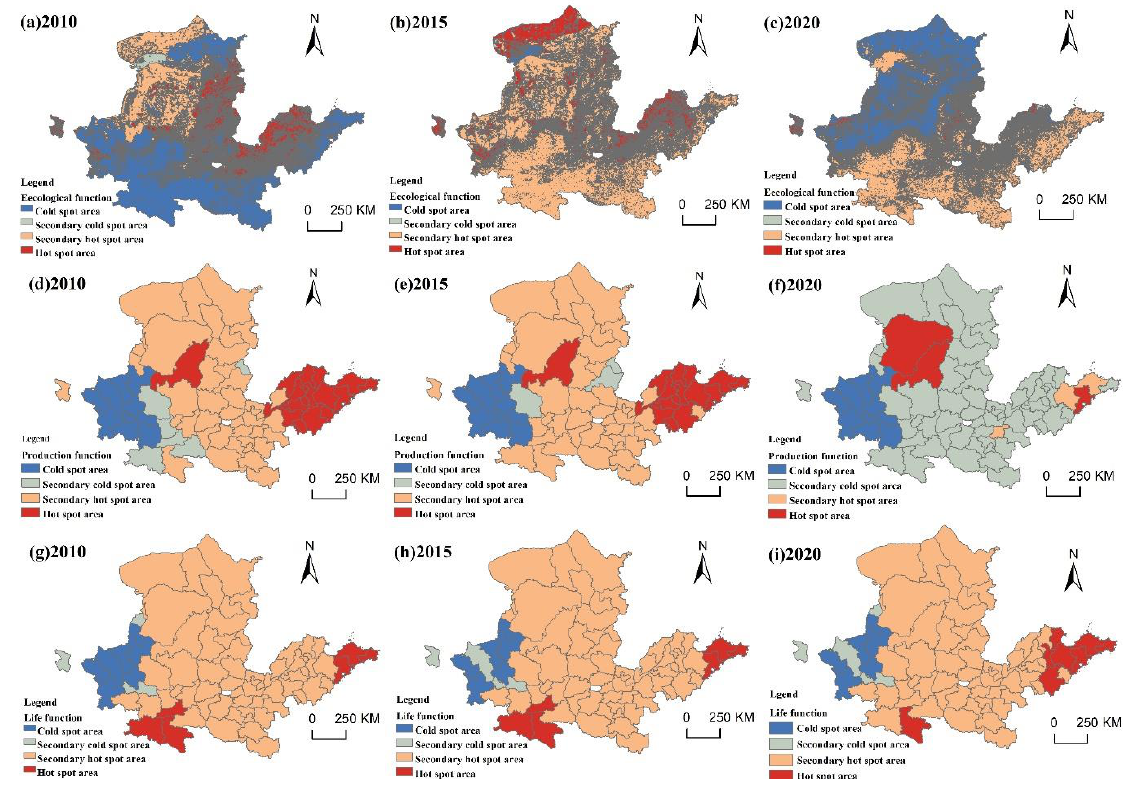
Figure 9. Agglomeration characteristics of the suitability of PLES.